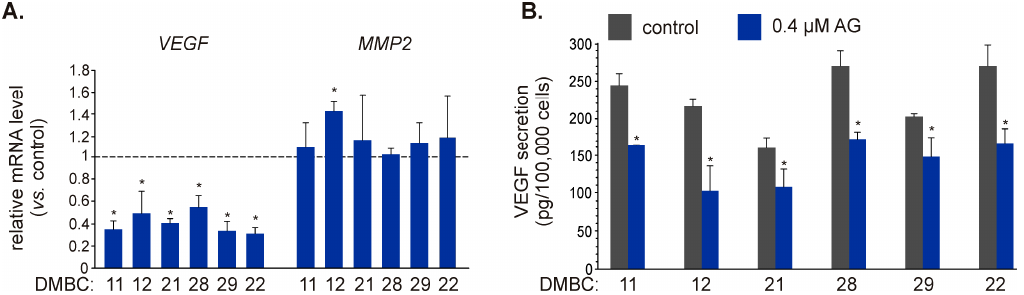
Figure 5. The influence of 17-aminogeldanamycin (AG) on the expression of NF- κ B-dependent genes that control angiogenesis and invasion. ( A ) The transcript levels of vascular endothelial growth factor ( VEGF ) and matrix metalloproteinase-2 ( MMP2 ) were assessed by qRT-PCR after 22 h and shown relative to the control. Data presented are mean ± SD; n = 3 (* p ≤ 0.05 vs. control). ( B ) Samples of the culture medium were collected after 24 h of melanoma cell incubation with 0.4 µM AG. The levels of VEGF protein were determined by ELISA. Data presented are mean ± SD; n = 3 (* p ≤ 0.05 vs. control).